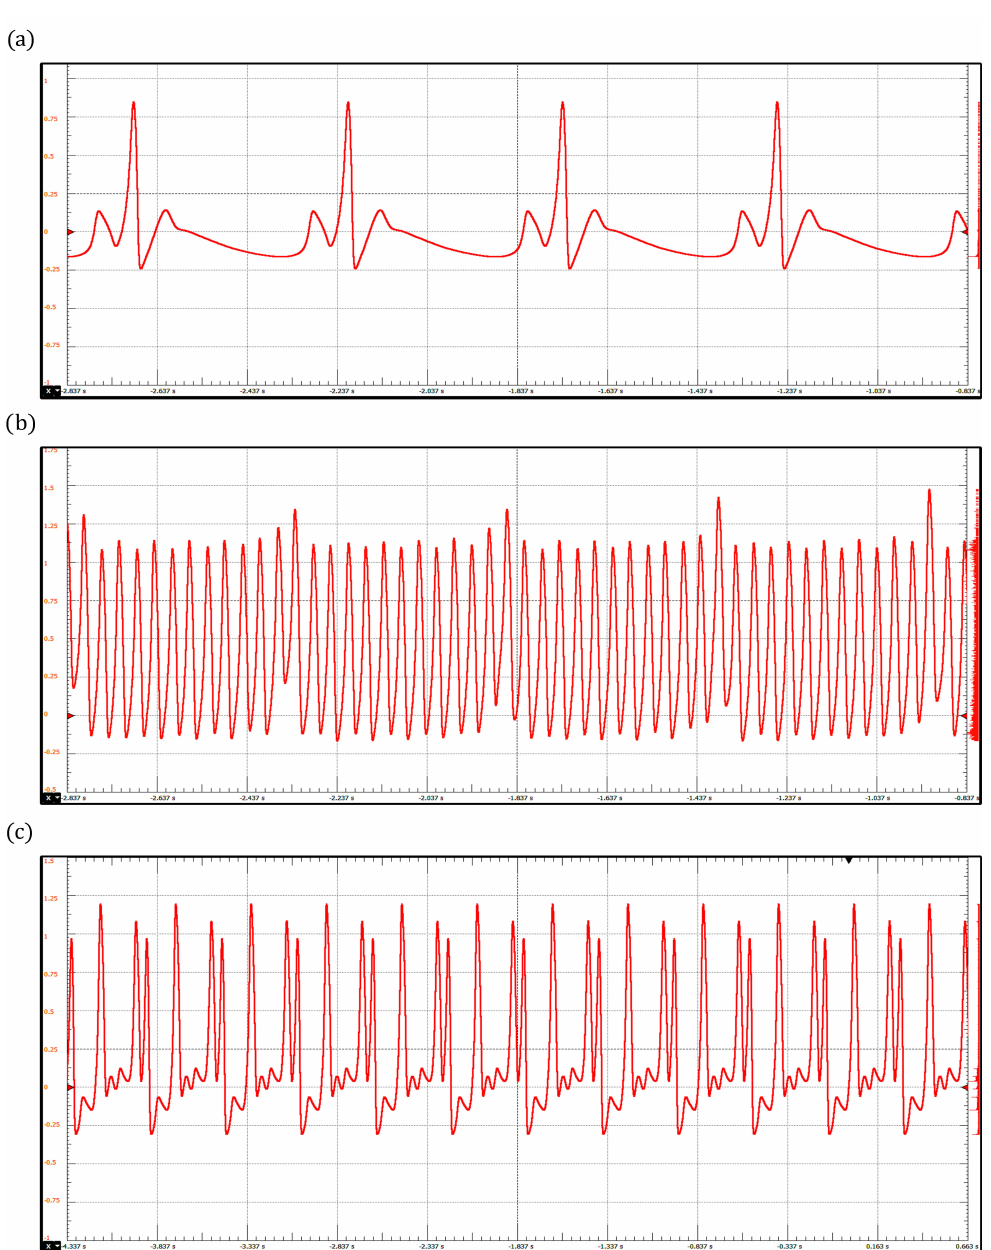
Figure 7. ECG waveforms obtained with the ring of three-coupled oscillators model: ( a ) Sinus Bradycardia, ( b ) Atrial Flutter, and ( c ) Ventricular